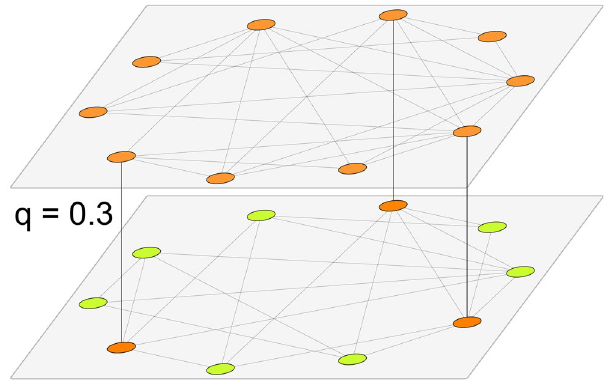
Figure 1. Sketch of the two-layer topology used in the simulations. In each layer, we have a network with N nodes and a fraction of q nodes connected inter-layers. The node colors represent the two possible opinion states. Nodes common to both layers are forced, by definition, to have the same state (color).